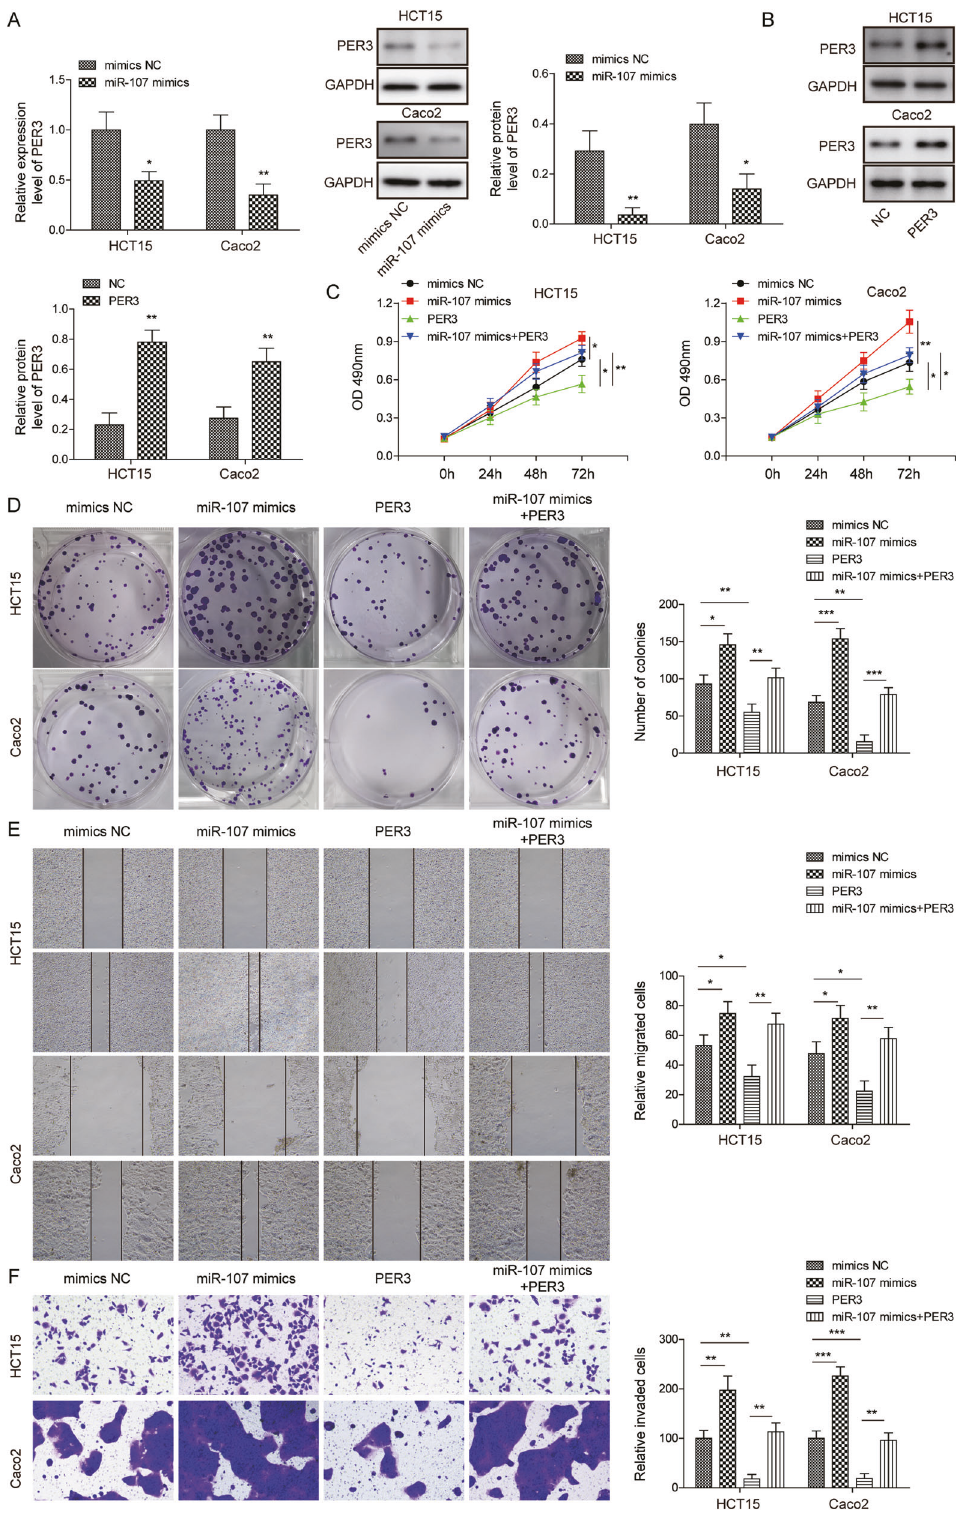
Fig. 6 miR-107 regulated CRC growth and metastasis via PER3 in vitro. A Relative PER3 mRNA levels in transfected Caco2 and HCT15 cells. B Relative PER3 protein levels in transfected Caco2 and HCT15 cells. C CCK-8 assay to measure cell viability. D Colony formation assay to assess cell proliferation. E Scratch wound assay to analyze cell migration ability. F Transwell assay to evaluate cell invasion ability.